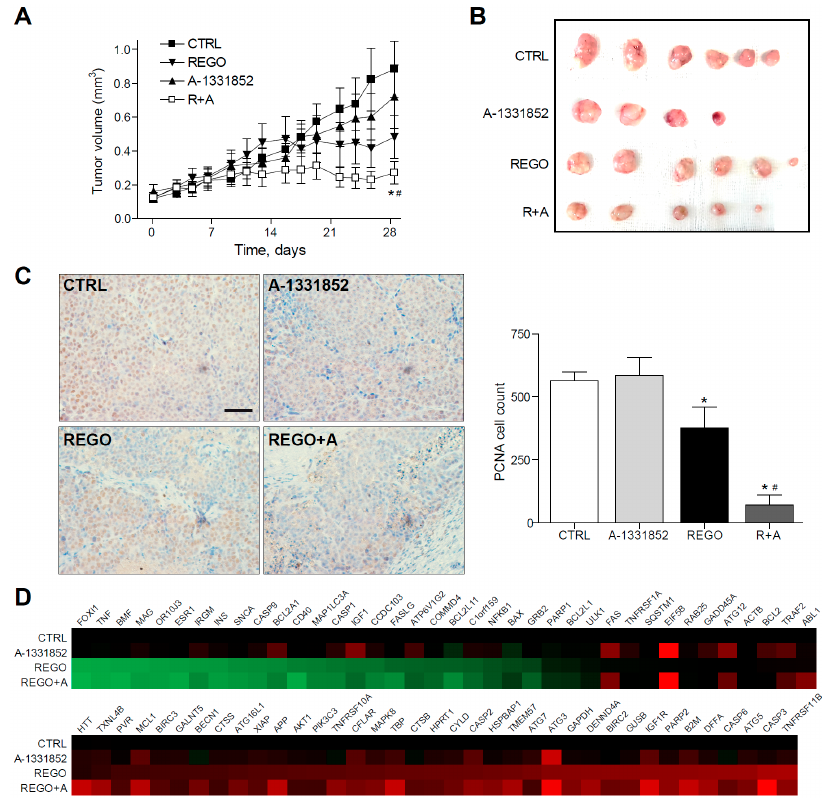
Figure 6. BCL-xL inhibitor A-1331852 remarkably reduced tumor growth in regorafenib-treated PDXs. ( A,B ), Subcutaneous growth quantification and images of BCLC9 tumors in mice treated with A-1331852 (25 mg/kg) and regorafenib (30 mg/kg) for 4 weeks (n = 4–6). * p < 0.05 vs. vehicle-treated mice. ( C ) Representative images of PCNA expression in tumor samples from BCLC9 PDXs and quantification (scale bar, 50 µm). ( D ) Transcriptomic analysis of cell death-related genes in BCLC9 tumors from nude mice treated with vehicle, regorafenib, and / or A-1331852. (n =